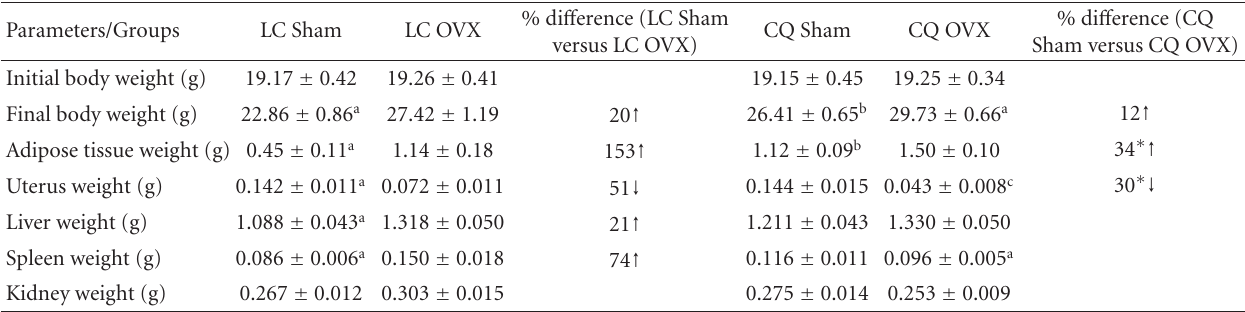
Table 1: E ff ects of Cissus quadrangularis on the body weight and weight of di ff erent organs of female ovariectomized C57BL/6 mice.